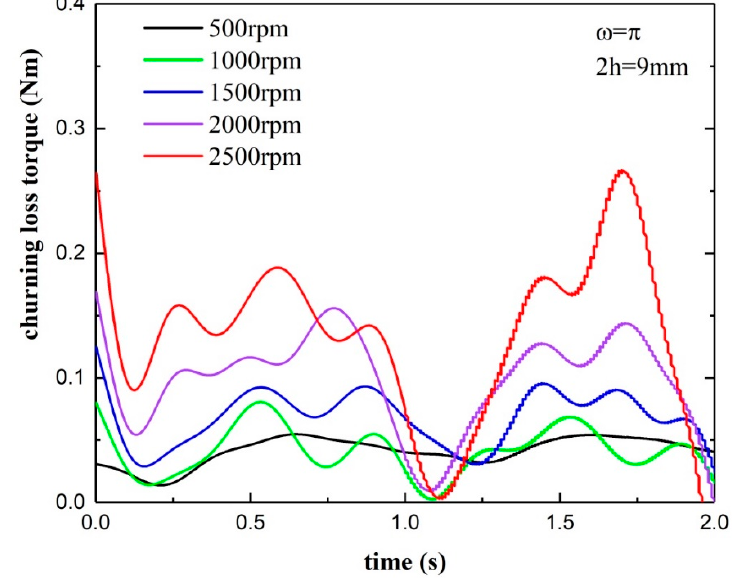
Figure 9. Time history curve of churning loss torque with rotational speeds.